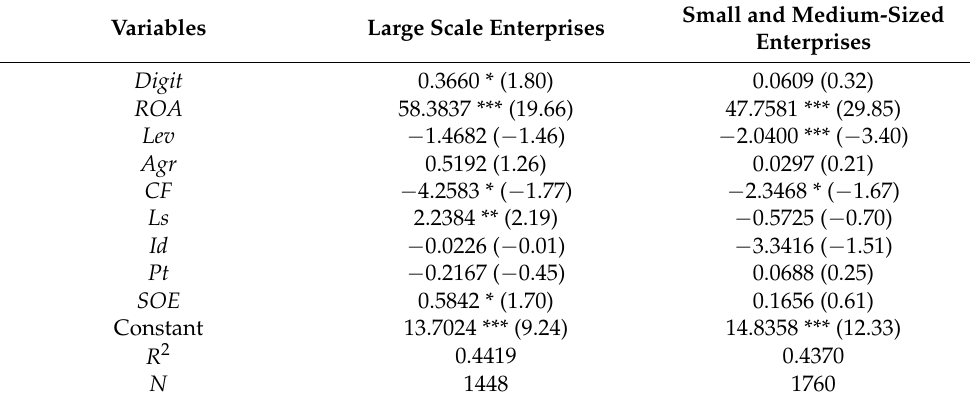
Table 12. Regression results of distinguishing enterprise